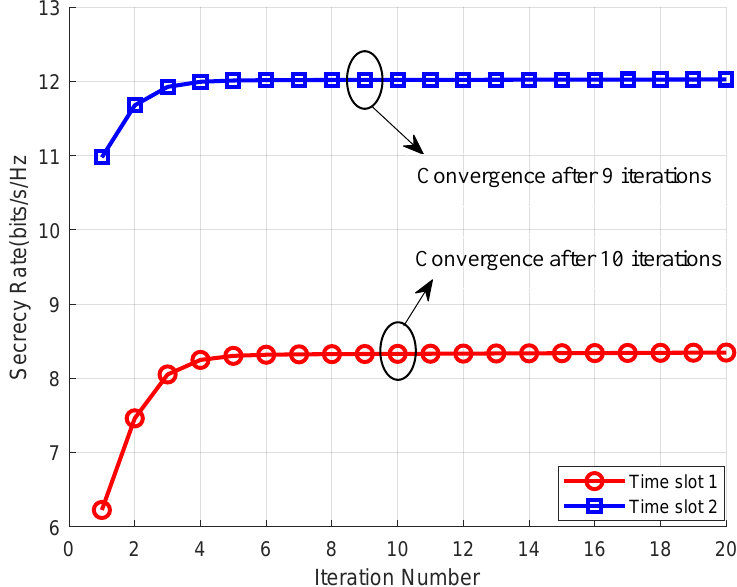
Figure 4. Convergence performance of the proposed iteration